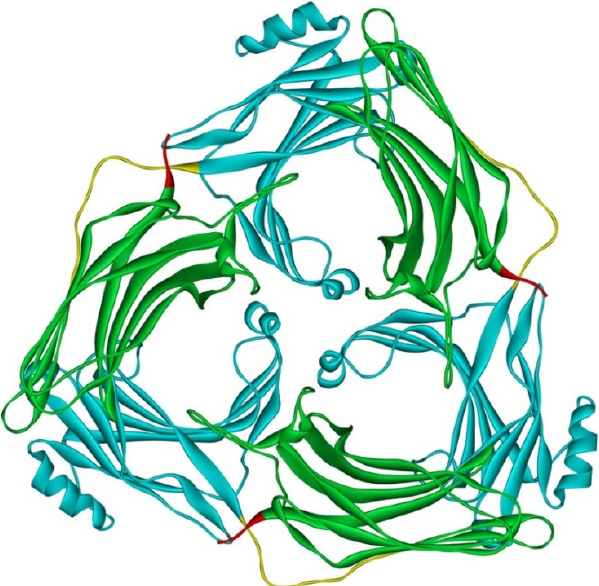
Figure 4. Crystal trimer of bovine arrestin-3 in the presence of IP6. PDB ID 5TV1 [79] . Protomers are linked via N-to-C contacts. Arrestin-3 appears to form the same trimers in the presence of IP 6 in solution [69]. Each protomer in the trimer is in receptor-bound-like conformation. In each protomer, arrestin-3 elements are colored, as follows: N-domain (residues 1–173), blue; inter-domain hinge (residues 174–185), yellow; C-domain (residues 186–345), green; resolved part of the C-tail (from residue 346), red. Image was created in DS ViewerPro 6.0 (Dassault Systèmes, San Diego, CA, USA).